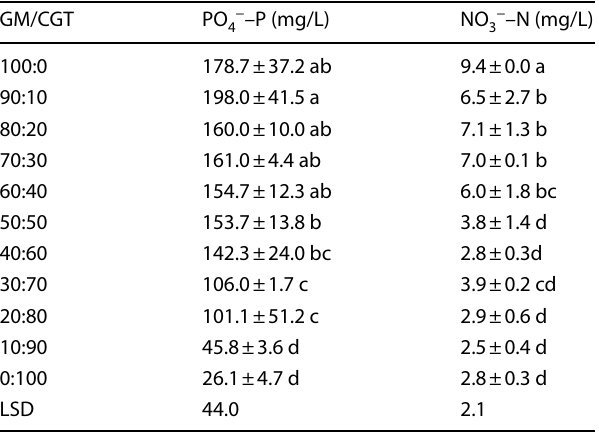
Table 4 Phosphate (PO 4− –P) and nitrate (NO 3− –N) concentrations in the liquid fraction of digestate from goat manure (GM) and cot- ton gin trash (CGT) mono and co-digestions